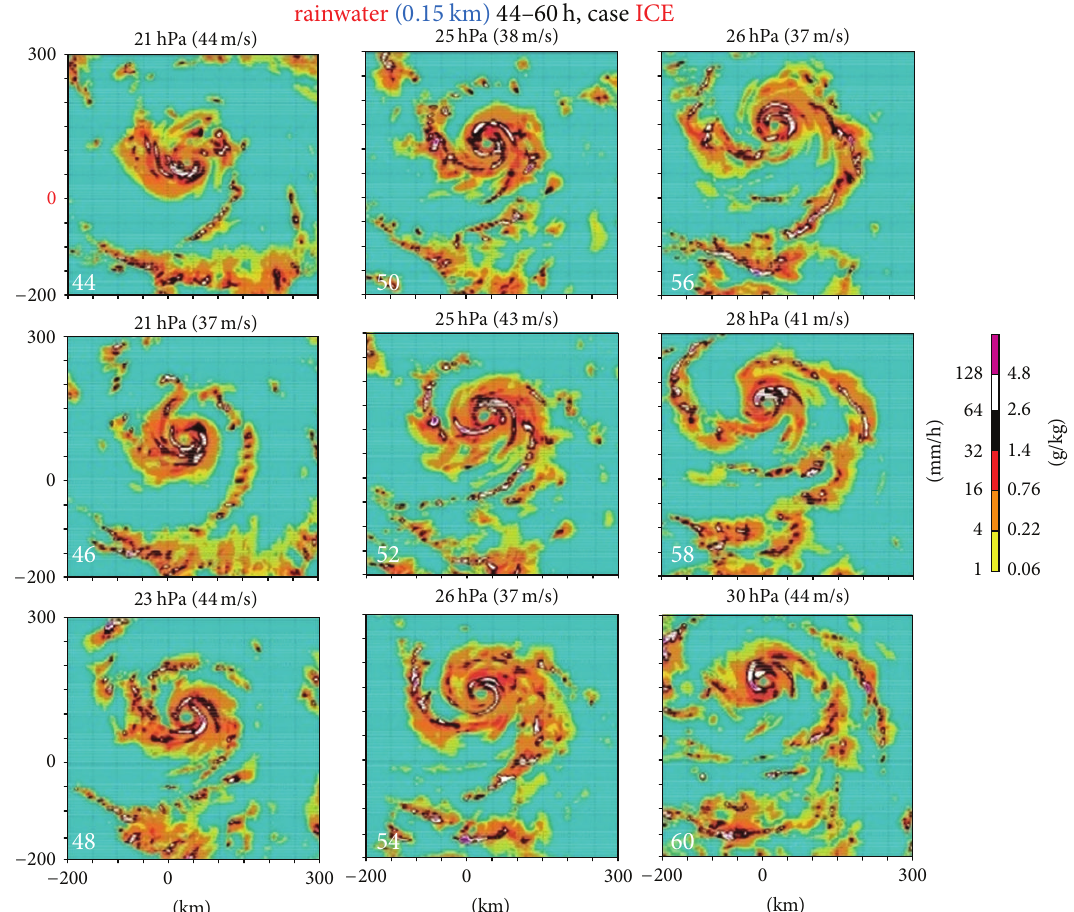
Figure 5: Rainwater mixing ratio at 0.15km, the central surface pressure, and the maximum wind speed at 1.25 km, at a time interval of 2 hours from 44 h to 60h in case ICE.